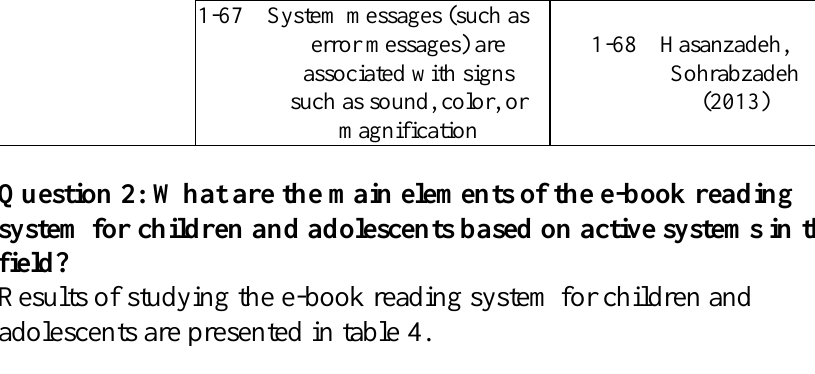
Table 4. Components in e-book systems 1-69